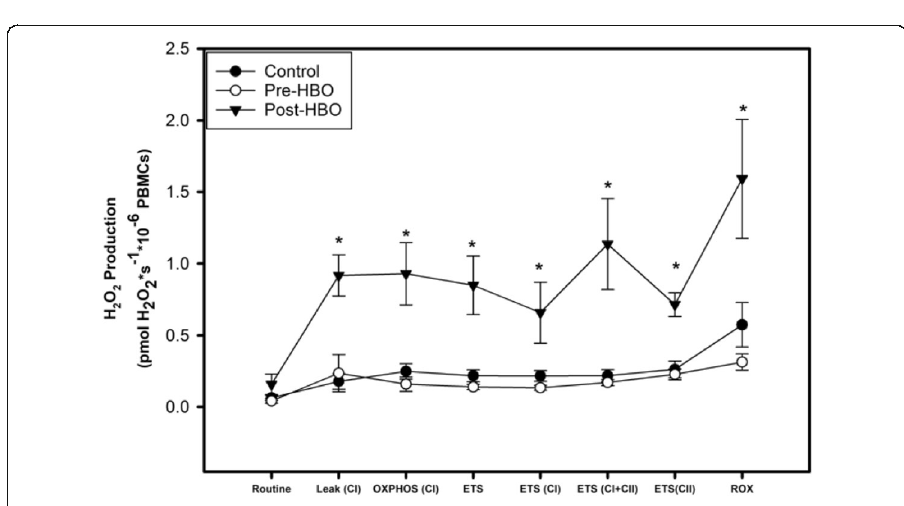
Fig. 4 ROS production in PBMCs. Measurement of ROS production using the Amplex Red assay. H 2 O 2 levels are measured in the presence of superoxide dismutase to ensure that all superoxide is converted into H 2 O 2 . Values presented as mean ± SEM. *The CO group (pre-HBO) is significantly different after their HBO treatment (post-HBO) and from the control group ( P < 0.001 for both